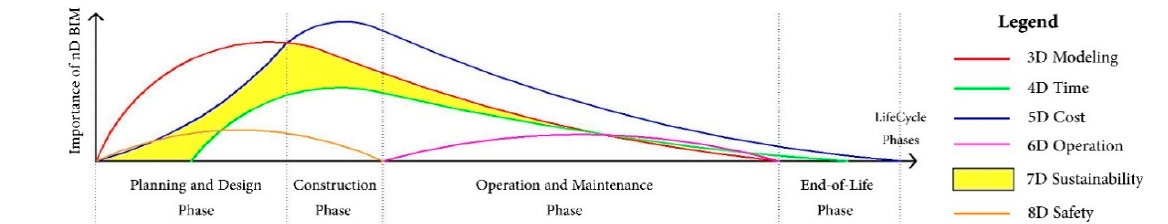
Figure 2. Level of importance of BIM dimensions over the entire life-cycle phases.